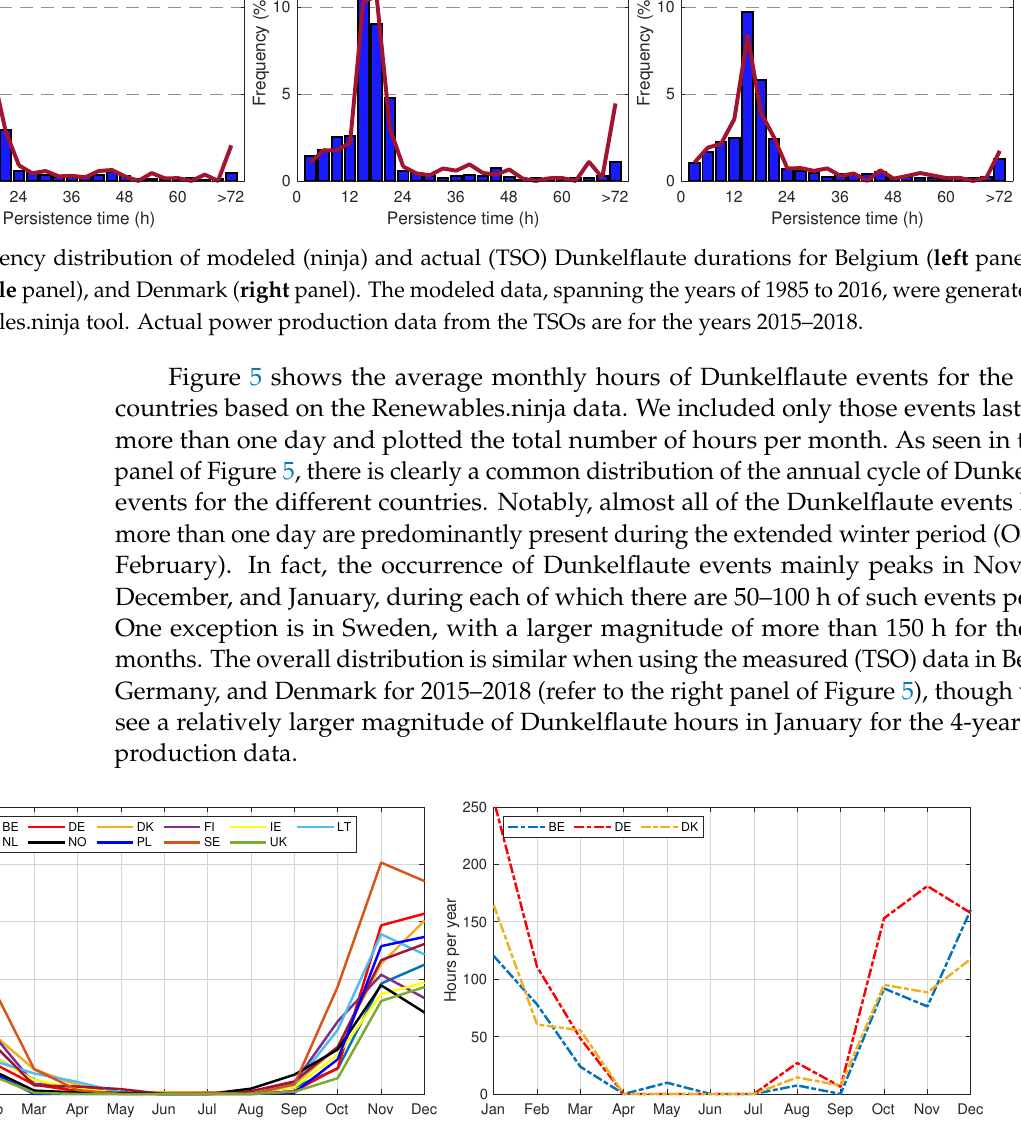
Figure 5. The ( left panel) shows the monthly variation of Dunkelflaute hours per year for eleven countries over the North Sea and Baltic Sea based on the Renewable.ninja data. The ( right panel) is similar but using actual production data from the TSOs to identify Dunkelflaute in Belgium (BE), Germany (DE), and Denmark (DK) for 2015–2018. We only account for the Dunkelflaute events longer than one